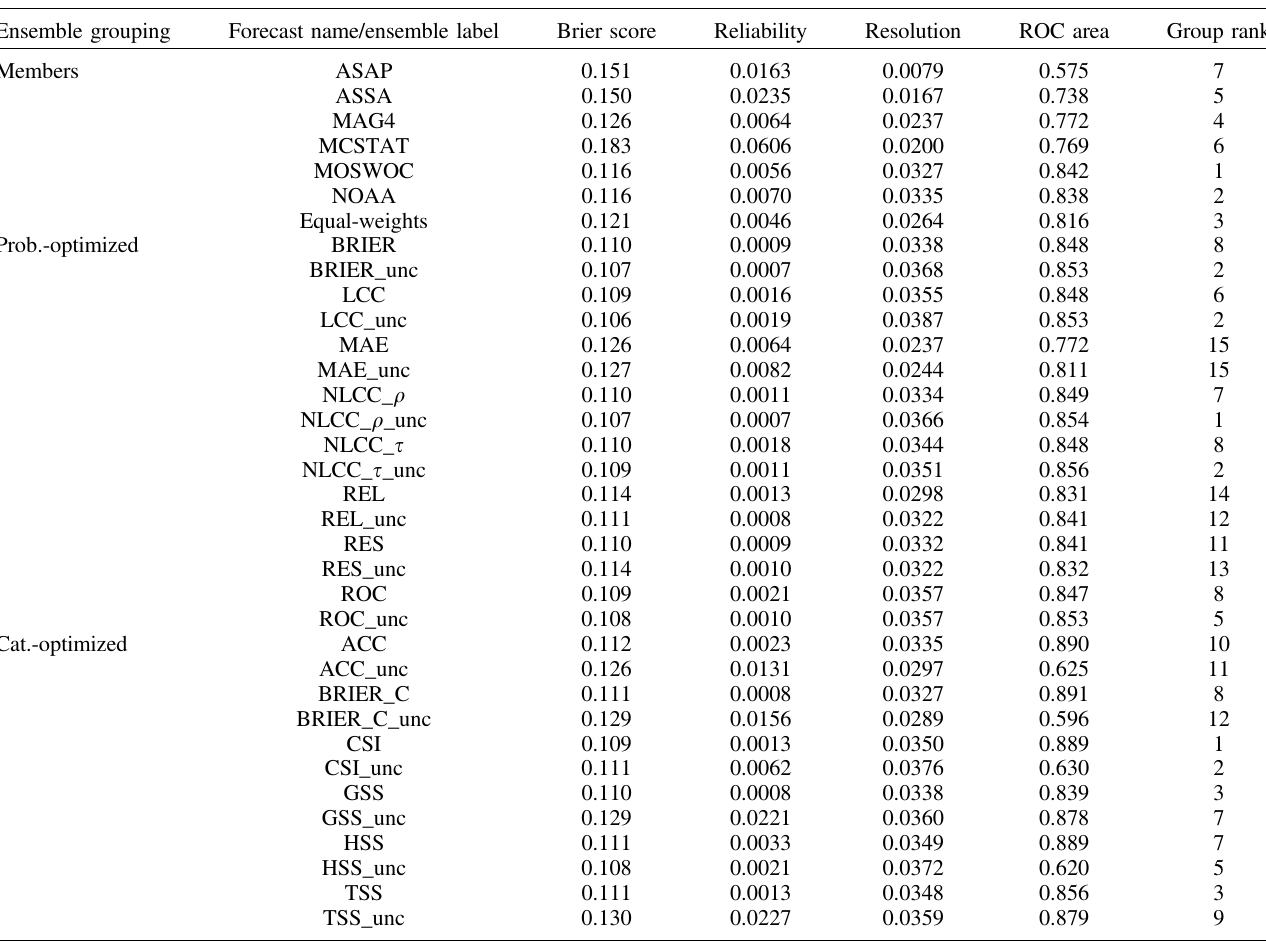
Table B.1. Table with validation metrics for M-class fl are forecasts. Note that there are 189 event days and 907 non-event days out of 1096 total days, and for all cases the decomposed Brier uncertainty is